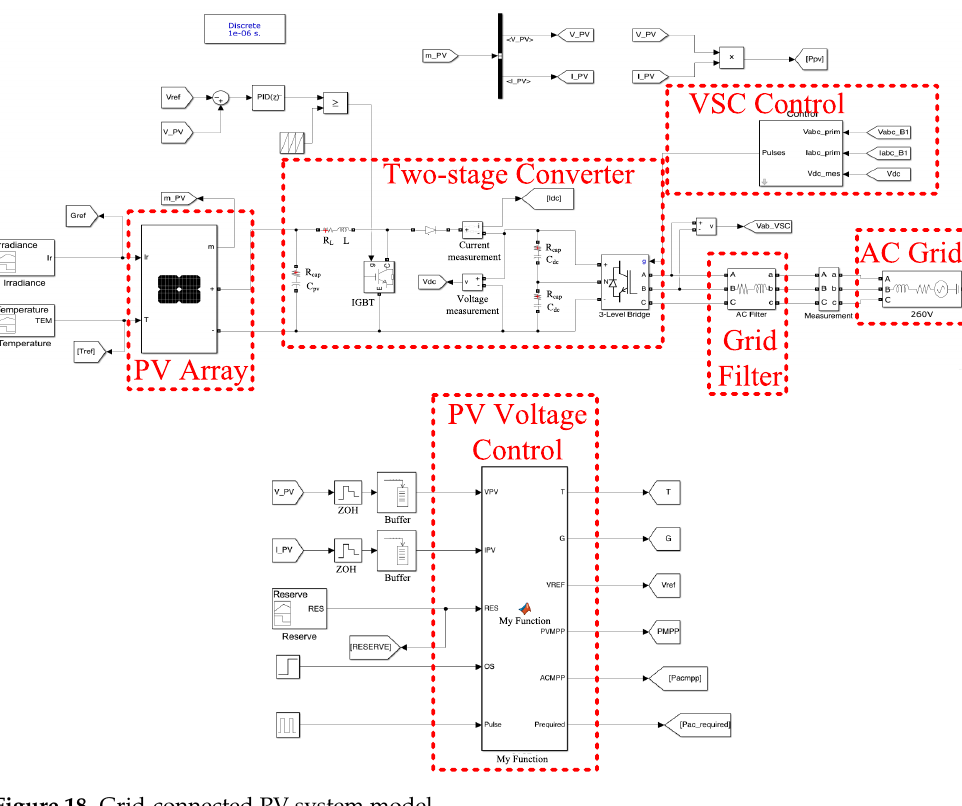
Figure 18. Grid-connected PV system model. Table 6. AC grid